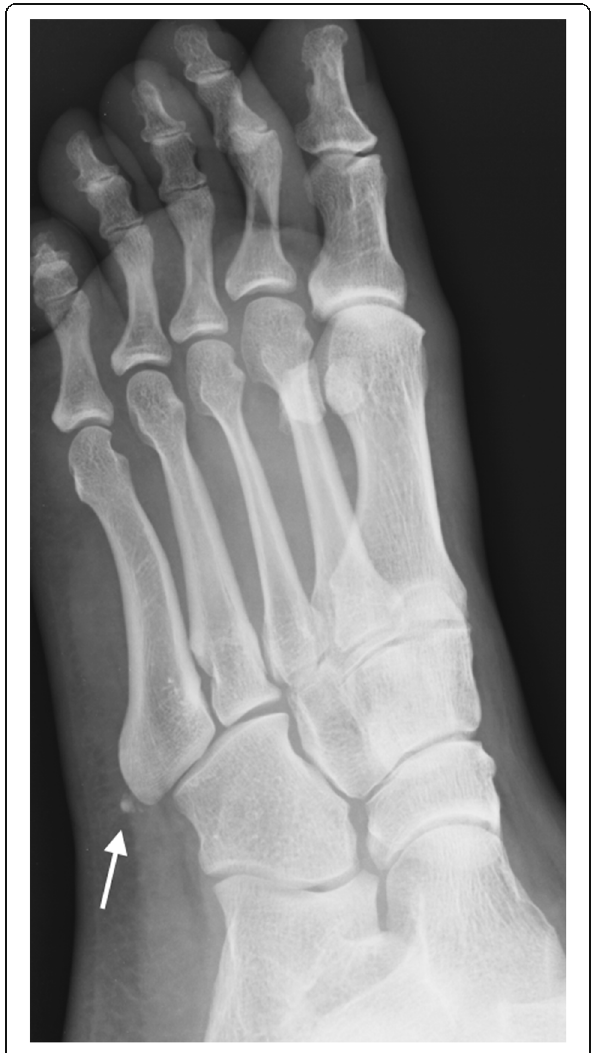
Fig. 16 Os vesalianum. Oblique radiograph. Incidental finding of a small os vesalianum (white arrow). These very rarely constitute a source of pathology